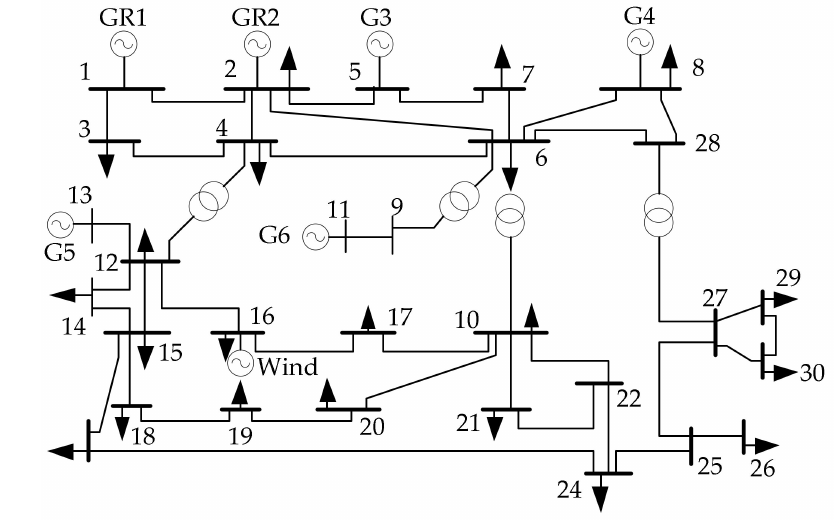
Figure 3. IEEE 30 node test system diagram. Table 1. Conventional unit parameters.